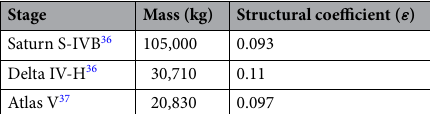
Table 1. Mass and structural coefficient for different launch